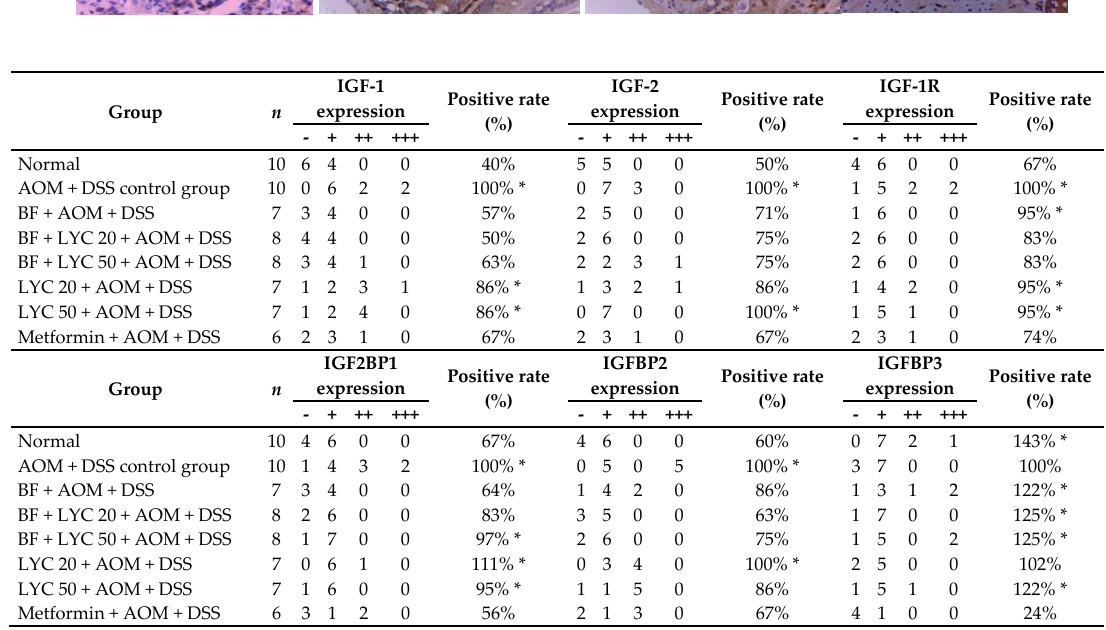
Figure 3. Histological features and IGF-I, IGF-2, IGF-IR, and IGF-binding proteins (IGFBPs) protein expressions in colonic tissues of AOM-DSS-treated mice. H&E staining: ( a ) Normal tissue; ( b ) Low grade inflammation ( + ); ( c ) Medium grade inflammation ( ++ ); ( d ) High grade inflammation ( +++ ); ( e ) Adenocarcinoma. Immunostaining: ( f , j , n ) Negative protein expressions were < 5% ( − ); ( g , k , o ) Weakly positive protein expressions were in the range of 5–24% ( + ); ( h , l , p ) Positive protein expressions were in the range of 25–50% ( ++ ); ( i , m , q ) Strongly positive protein expressions were > 50% ( +++ ). Image captured at × 400). Positive rate (percentage of treated group / AOM + DSS control group). n = 6–10 mice per group. * Incidence is statistically significant by chi-square test ( p <